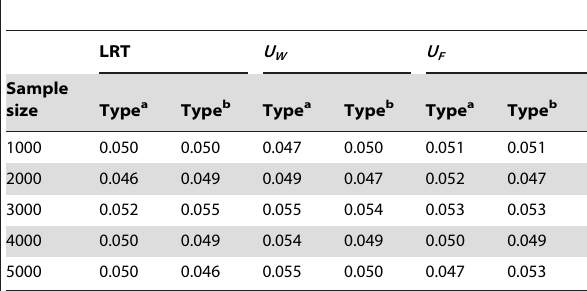
Table 1. Type I error for three statistics without correlation and interaction.